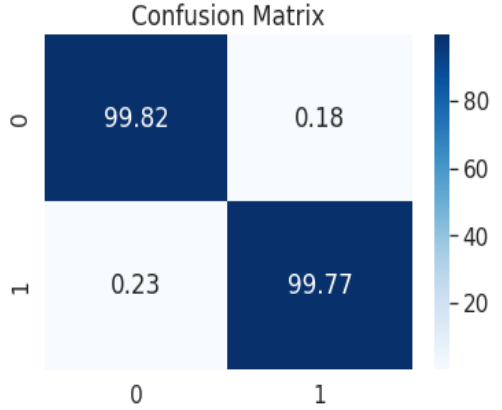
Figure 20. Confusion matrix from the predicted value after tumor segmentation, achieving an Acc of 99.6% and a Dice coefficient of